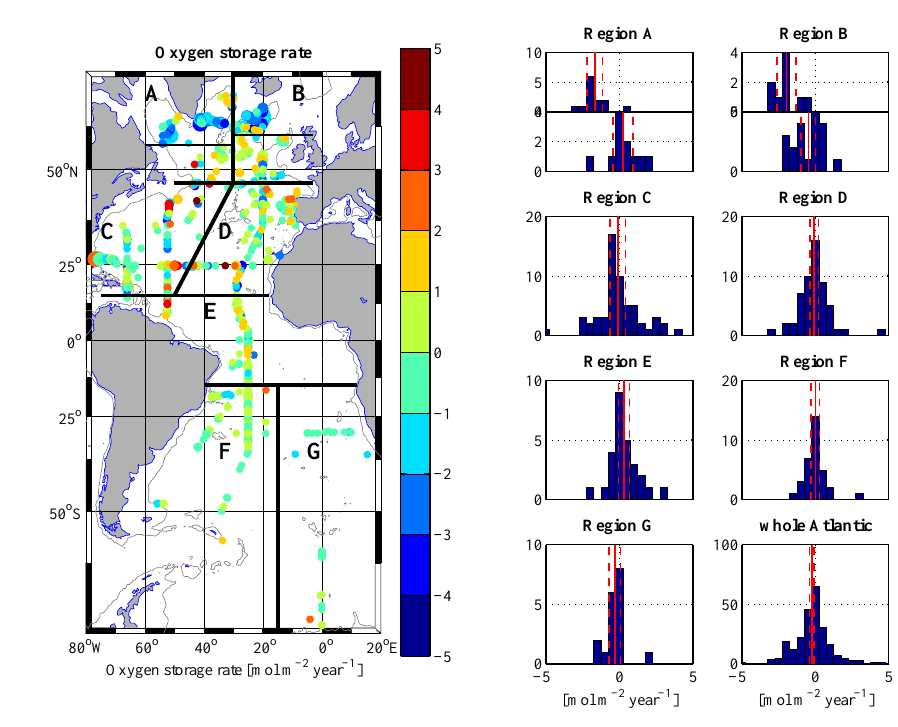
Fig. 4. Same as Fig. 2 but for storage rates (molm − 2 yr − 1 ) of